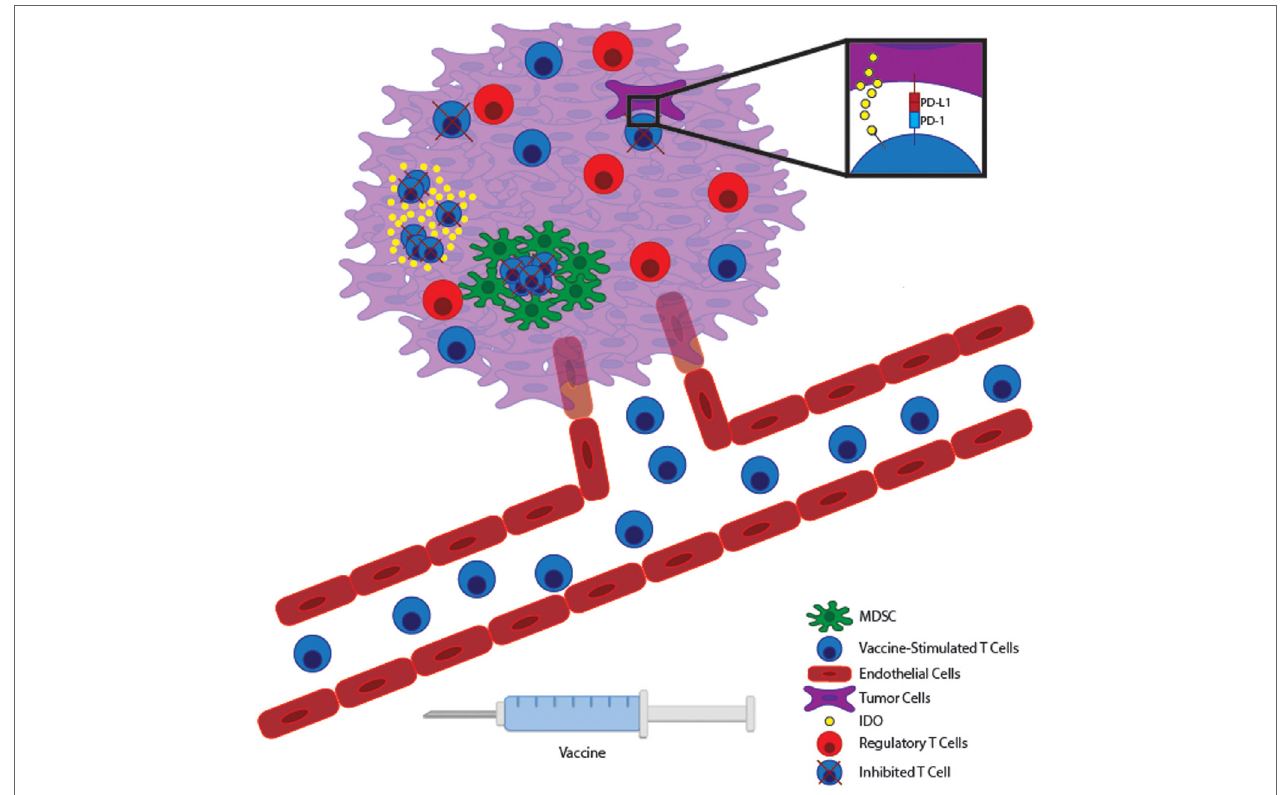
FiGURe 1 | Vaccine-stimulated T cells encounter many immunosuppressive pathways within the tumor microenvironment. Immunogenic tumor vaccines will stimulate tumor-reactive T cells to expand within lymphoid tissue and migrate through the vasculature to the tumor bed. Within malignant tissue, T cells can potentially encounter many immunosuppressive pathways. Tumor cells can express inhibitory molecules, such as PD-L1 and IDO, which suppress T cell effector function and allow tumor immunoevasion. At the same time, many tumors promote the accumulation of regulatory immune cells, such as myeloid-derived suppressor cells (MDSCs) and Tregs to further inhibit effector T cell function locally. Therapies targeting these local immunoevasive pathways may allow vaccine- stimulated T cells to maintain full functionality within a hostile tumor